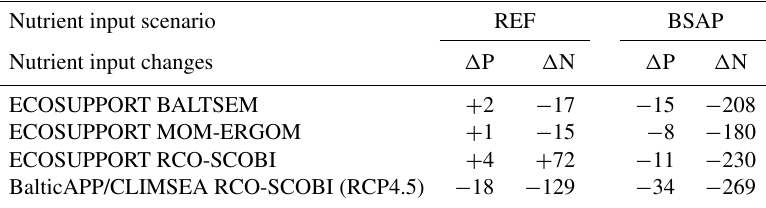
Table 6. Projected ensemble mean changes in total (land and atmosphere) bioavailable annual phosphorus ( (cid:49) P) and nitrogen ( (cid:49) N) inputs (in ktons) into the Baltic Sea between historical (1980–2005) and future (2072–2097) climates under the scenarios REF and BSAP. (Source: Meier et al., 2018a; their Fig.